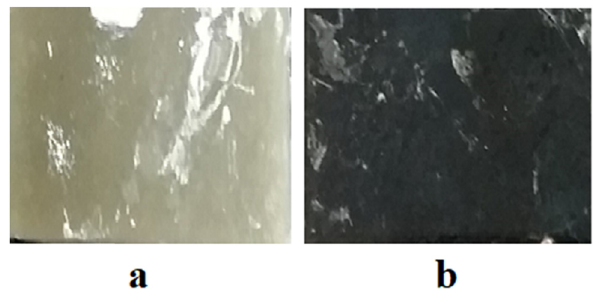
Figure 11: ( a – b ) : Water absorption test